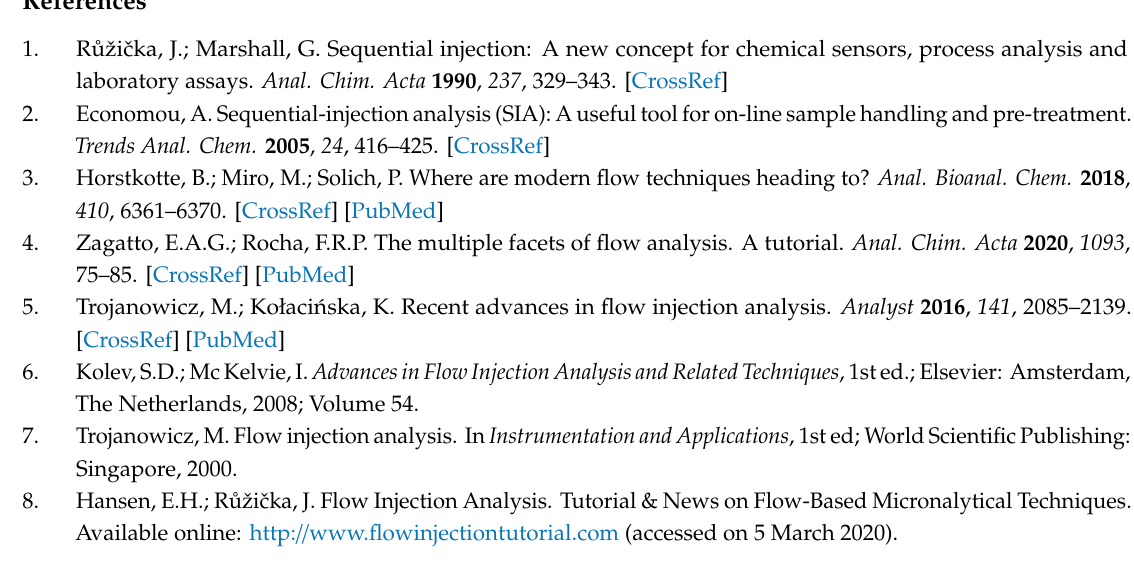
Figure S2: Preparation of a brush-less motor for in-syringe stirring; Figure S3: Typical signal dependencies in the optimization of DLLME protocols automated by